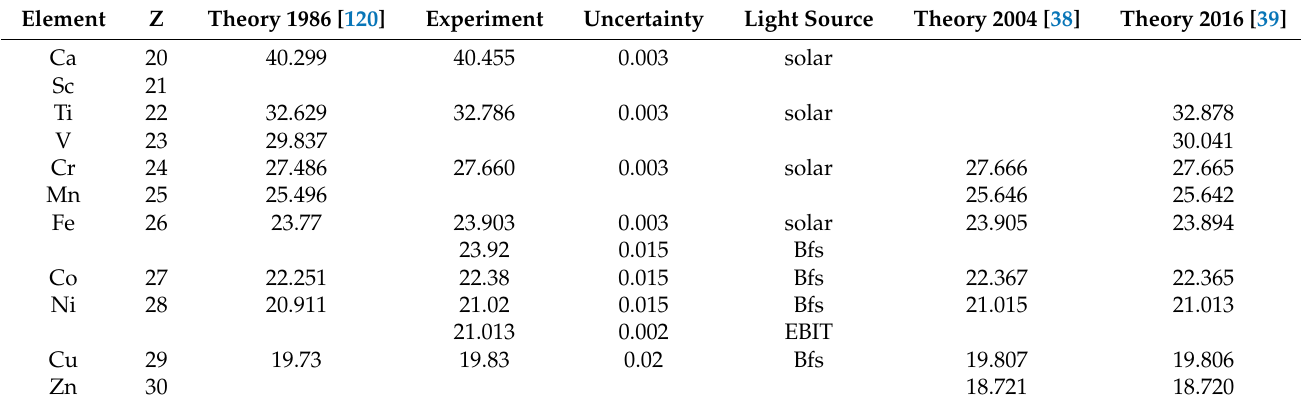
Table 1. Computed and measured wavelength results (in nm) on the 3s 2 3p 2 3 P 2 –3s 2 3p3d 3 F o data refer to [121]; Bfs data have been obtained by beam–foil spectroscopy as explained in the text; EBIT data have been obtained at an electron beam ion